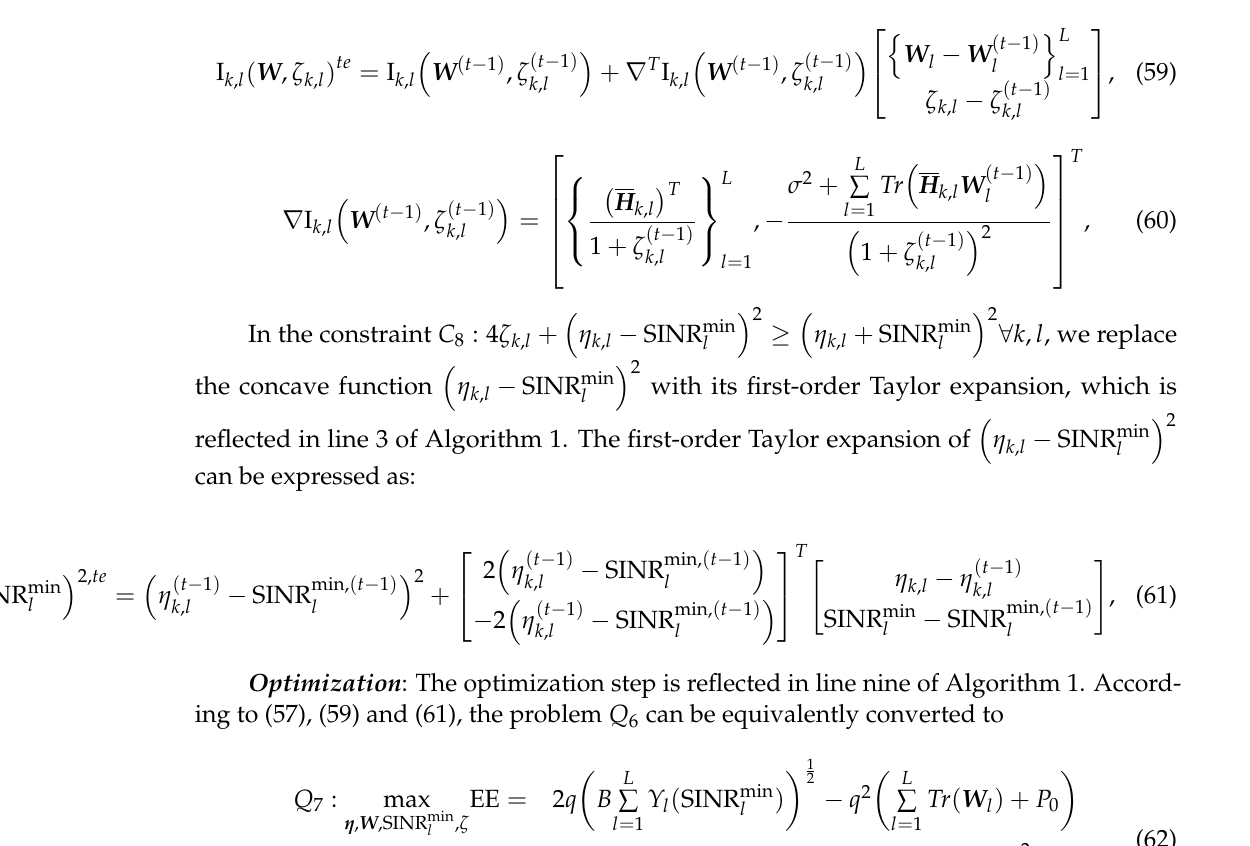
Algorithm 1. The first-order Taylor expansion of I k , l ( W , ζ k , l ) can be expressed